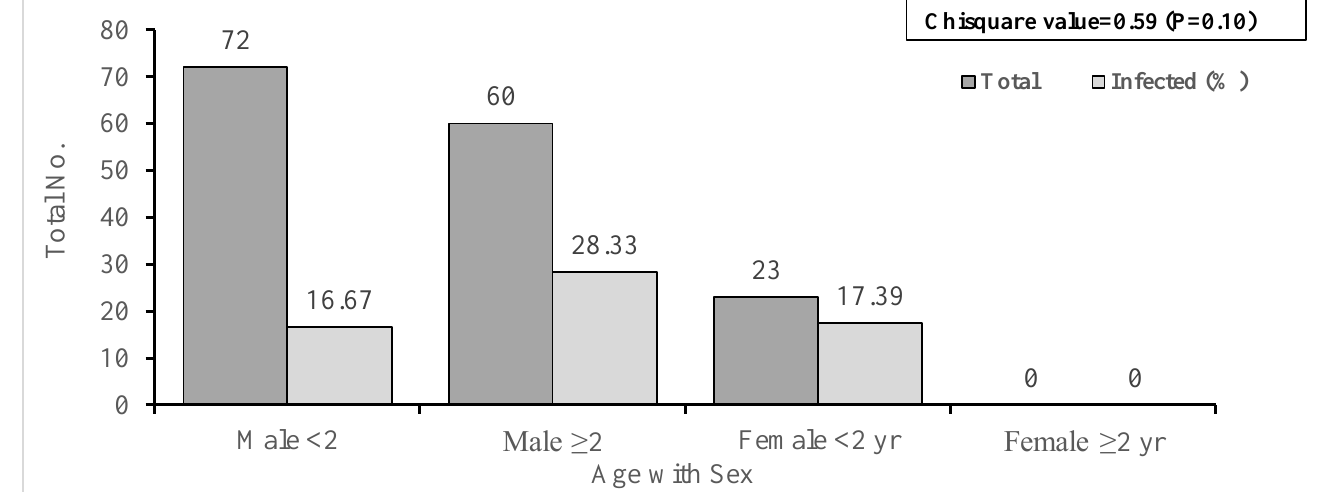
Figure 3. Comparison between males and females of Iraqi camels in the infection rate with Trypanosoma evansi according to age. n= 132 for males, n=23 for females